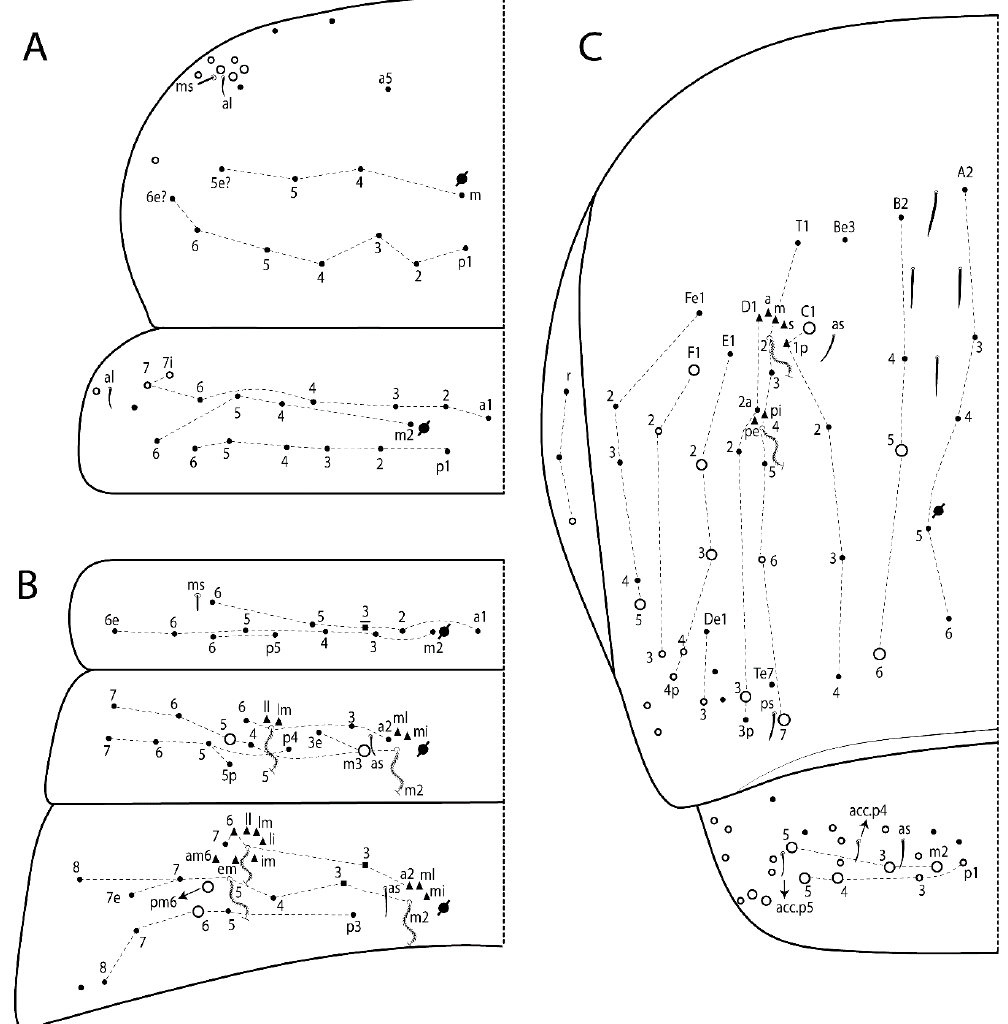
Figure 70. Pseudosinella macrolignicephala sp. nov.: dorsal chaetotaxy. ( A ) Th II–III; ( B ) Abd I–III; ( C ) Abd IV–V.